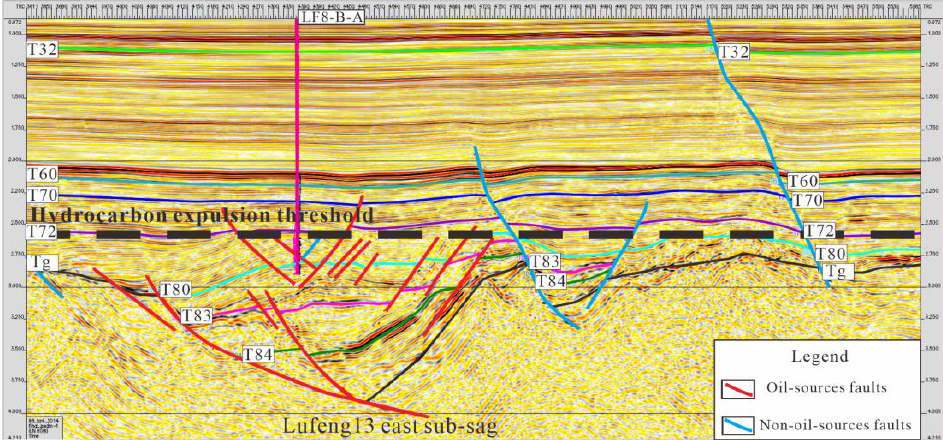
Figure 11. Distribution map of the oil–source fault and non-oil–source fault in seismic profile (the location of the seismic section is shown in Figure 1c B-B’).